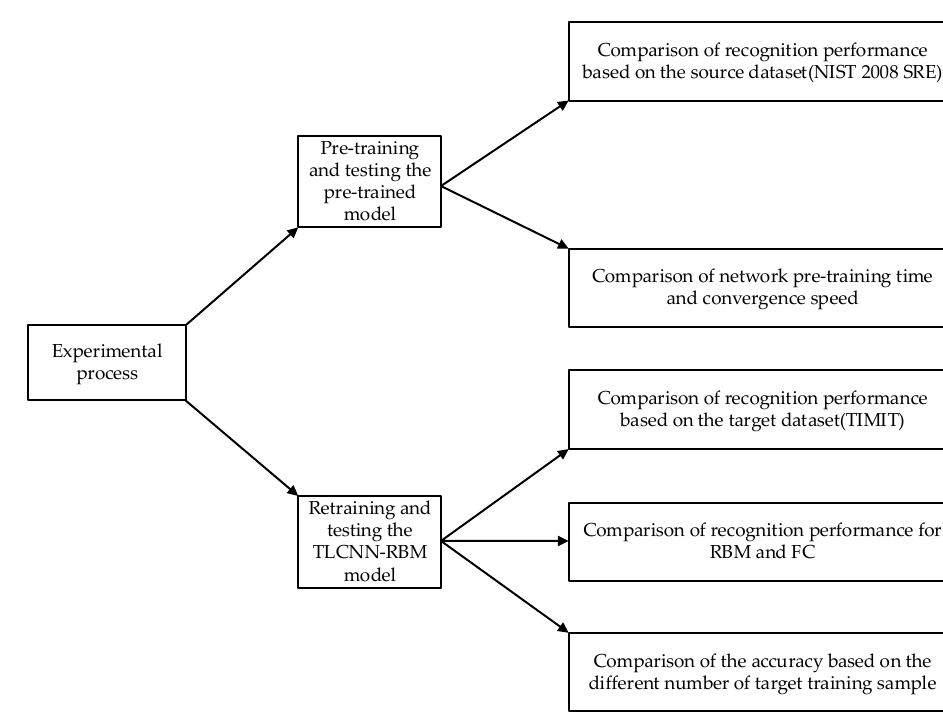
Figure 8. Experimental flowchart.